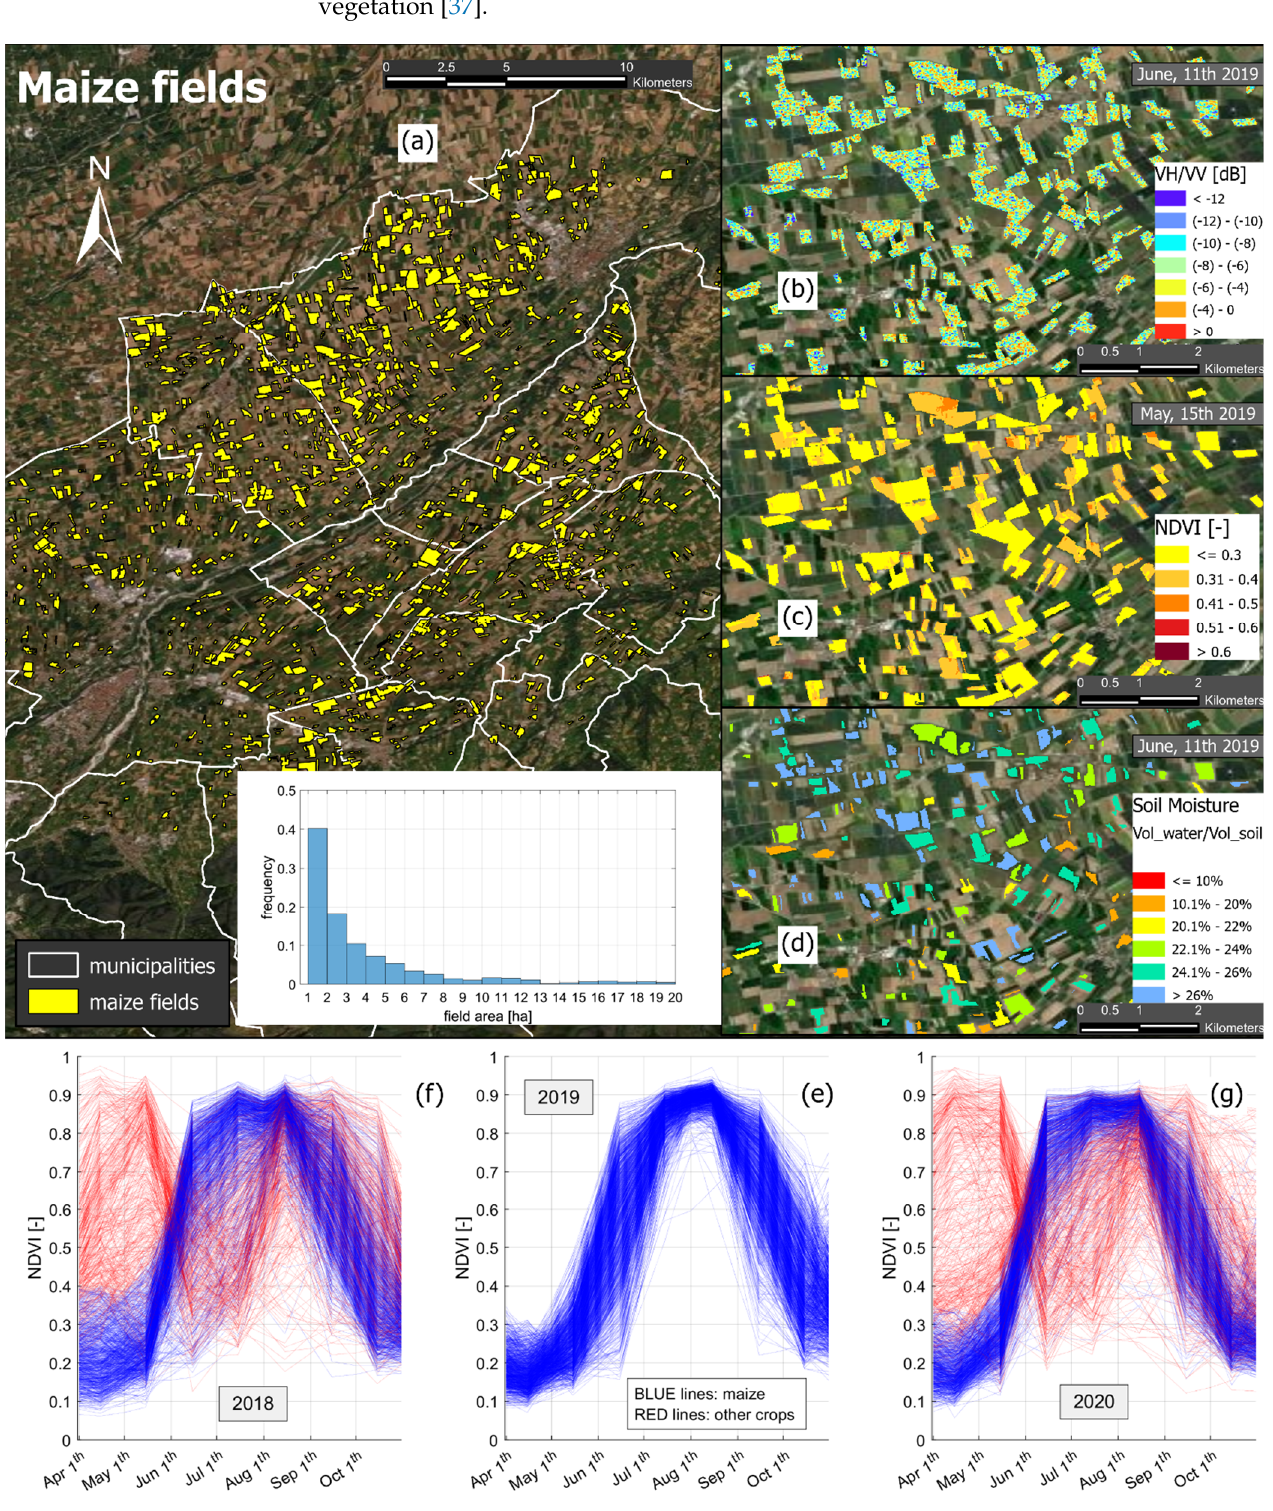
Figure 2. ( a ) Spatial distribution of maize fields over the studied region and frequency distribution of field areas. ( b ) Example of VH/VV 10 × 10 m data over the maize fields. ( c ) Example of NDVI 10 m × 10 m data over the maize fields. ( d ) Example of soil moisture 10 m × 10 m data over the maize fields. ( e ) NDVI series for 1154 fields classified as “maize” in 2019. Comparison with NDVI from same fields in 2018 ( f ) and 2020 ( g ).